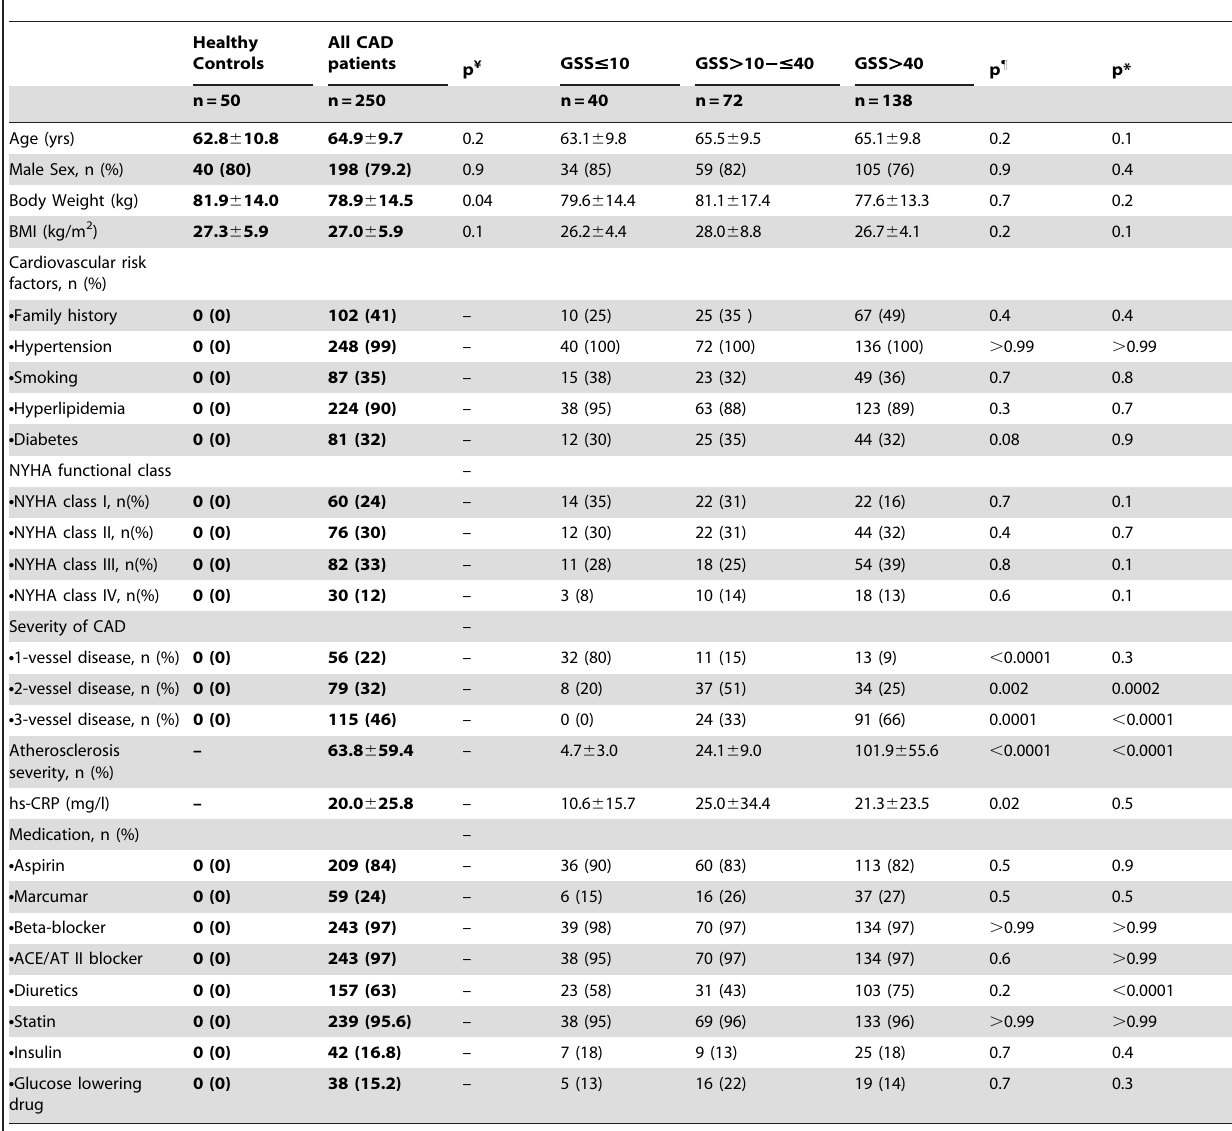
p ¥ =p-value comparing all CAD patients vs healthy controls, p " = p-value comparing CAD patients with GSS # 10 vs CAD patients with GSS . 10 2# 40, p* = p-value comparing CAD patients with GSS . 10 2# 40 vs CAD patients with GSS . 40. Abbreviations: ACE: Angiotensin-converting enzyme , AT II: Angiotensin II receptor blockers , BMI: body mass index, CAD: coronary artery disease, hs-CRP: high sensitivity C- reactive protein, kg: kilogram, LVF: left ventricular function, n: number, NYHA: New York Heart Association, yrs: years.